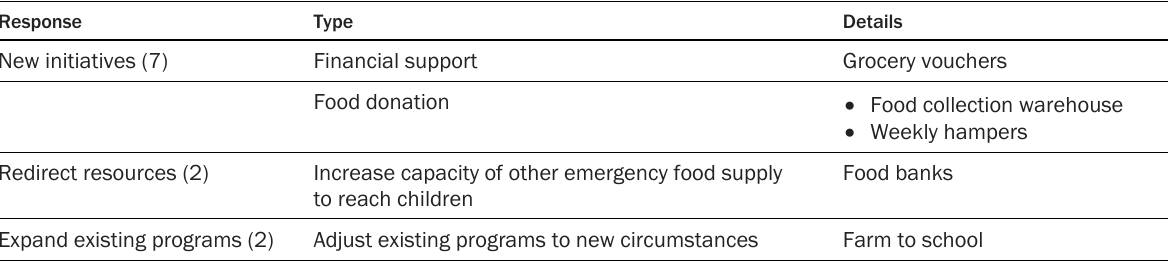
Table 4. SNP Response to COVID-19: New Initiatives and Changed Service Delivery